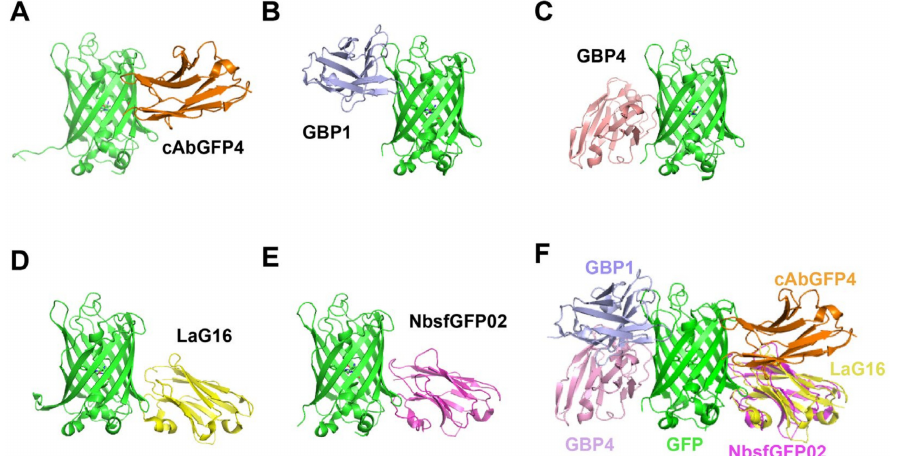
Figure 4. Diagram of GFP–nanobody complex. ( A ) cAbGFP4 (PDB:3OGO, orange); ( B ) GBP1 (PDB: 3K1K, light blue); ( C ) GBP4 (PDB: 3G9A, pink); ( D ) LaG16 (PDB: 6LR7, yellow); ( E ) NbsGFP02 (PDB: 7E53, magenta). ( F ) Structural superposition of above nanobodies with GFP complex. GFP is shown in green